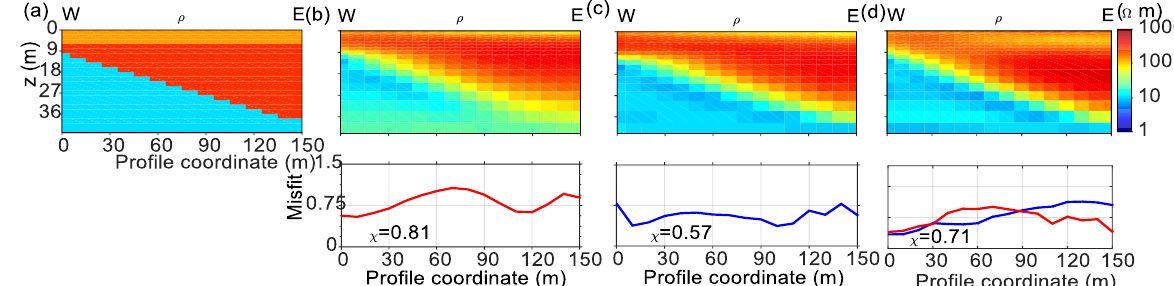
Figure 11. Comparison between the true resistivity value ( a ) and resistivity-inversion results of the non-IP responses of the moderate chargeable medium: x -data only ( b ); z -data only ( c ); and x and z data ( d ). The meanings of the curves and the area are the same as in Figure 7.